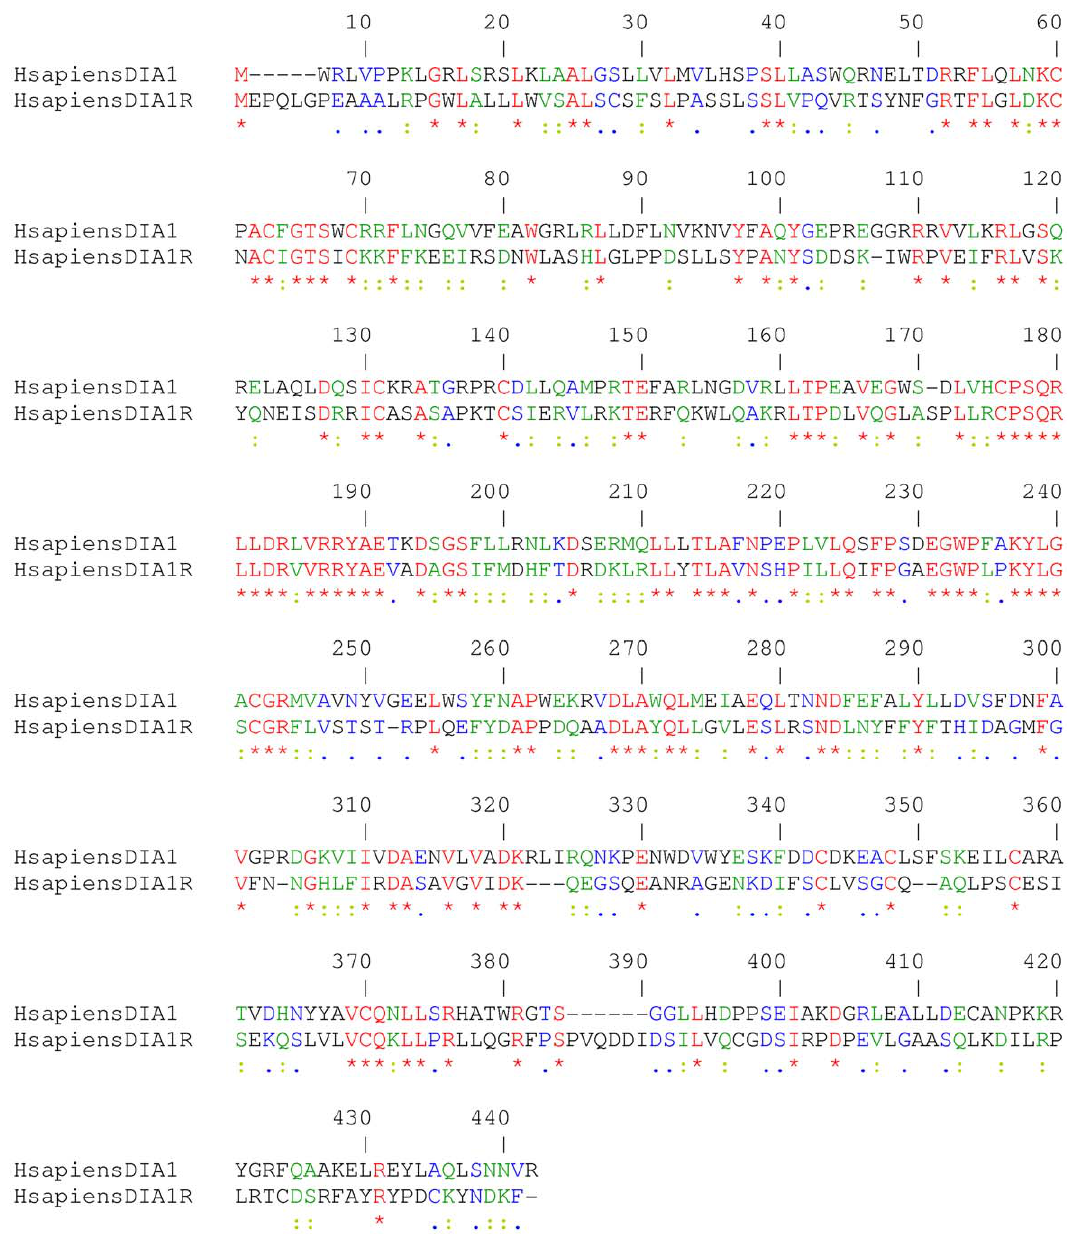
Figure 2. Amino acid sequence comparison of human DIA1 and human DIA1R. The sequence alignment was generated using CLUSTALX [164]. Identical amino acids are highlighted in red font and indicated below the alignment with an asterisk (*). Strongly similar amino acids are highlighted in green font and indicated below the alignment with a colon (:). Weakly similar amino acids are highlighted in blue font and indicated below the alignment with a full stop (.). Dissimilar amino acids are in black font. Amino acid numbering is provided above the alignment. Human DIA1 is 430, and DIA1R 433, amino acids in their immature forms (before signal peptide cleavage). Gaps required for optimal alignment are indicated by dashes. The two proteins have 28% identical, 21% strongly similar, and 13% weakly similar, residues. Standard single-letter amino acid abbreviations are used.